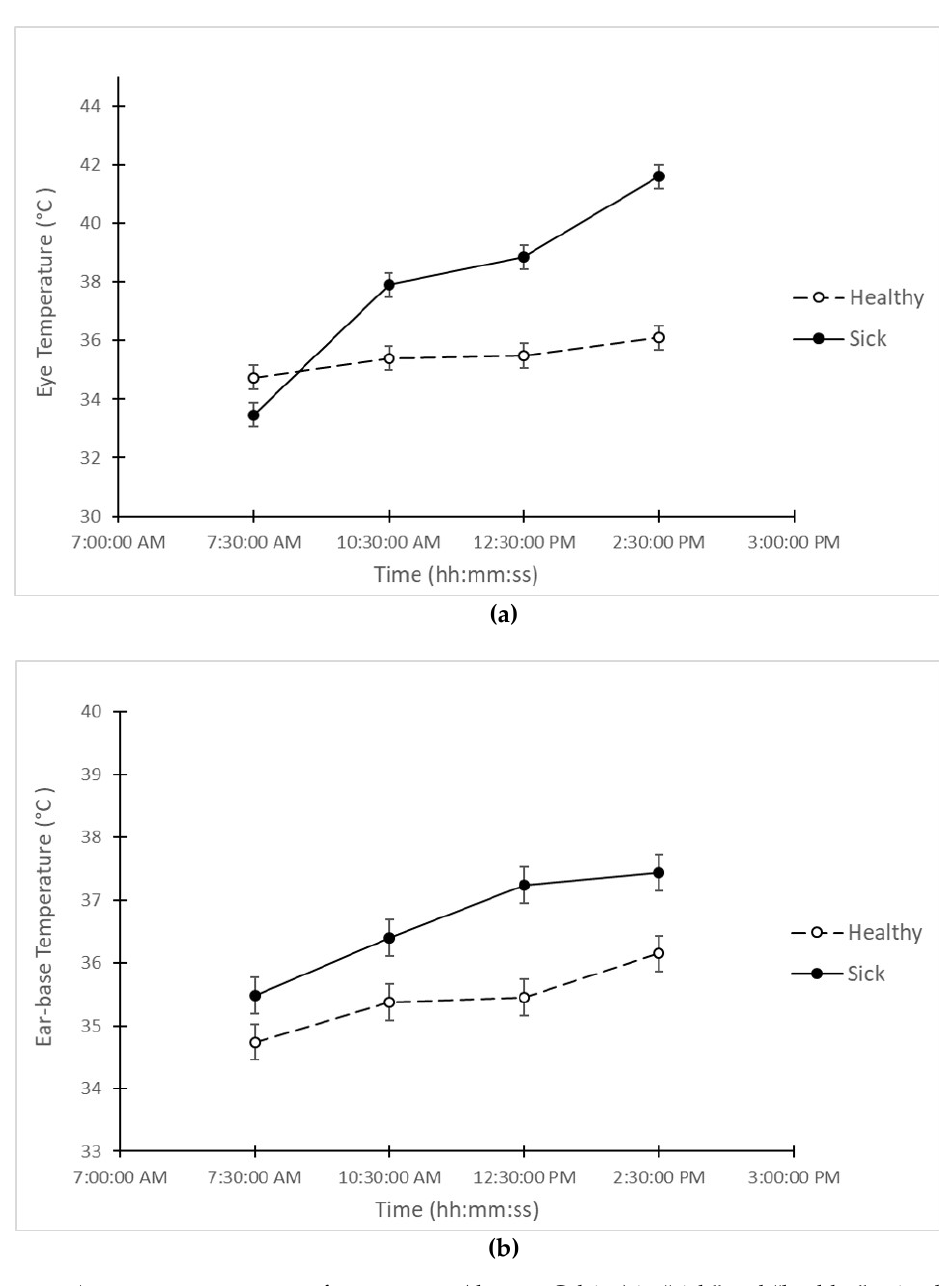
Figure 2. Average measurements of temperature (degrees Celsius) in “sick” and “healthy” animals at all 4 time points on the day after the challenge. On ( a ) eye temperature. On ( b ) ear-base temperature. Heart rate also showed larger changes in the “sick” pigs than in the “healthy” pigs, when comparing the measurements at all 4 time periods (Figure 3). The average HR of the “sick” group increased from 82.8 BPM at 7:30 to 107.9 BPM at 14:30. On the other hand, the average HR of the “healthy” group only increased from 76.2 to 82.5 during the same period. In addition, the difference of HR between “sick” and “healthy” animals increased from 6.62 to 25.37 (BPM) between 7:30 and 14:30, showing significant differences across all time points (LSD = 5.46; p < 0.05).